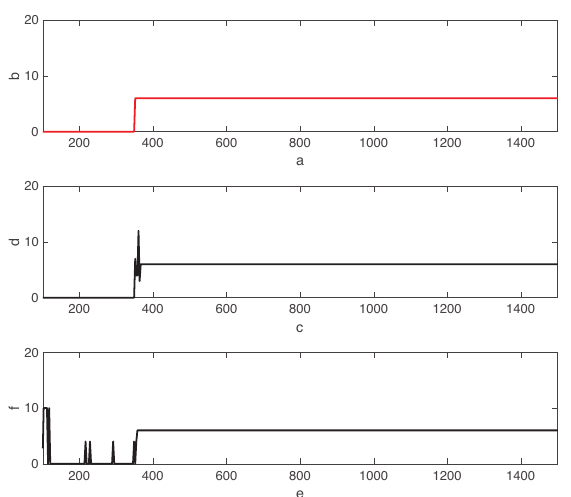
Figure 11. Transient behavior of the fault state and the prediction using LSTM and DCNN. Fault 06 is introduced to the normal state at 380 min.